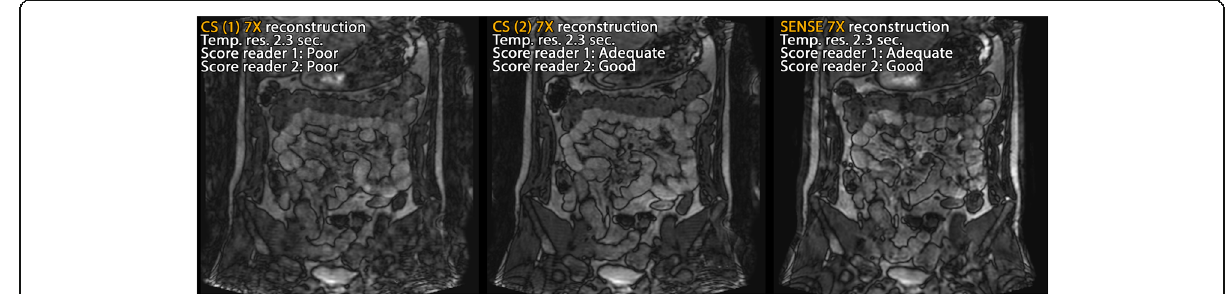
Fig. 9 Reconstructions from a representative time frame of a 7× accelerated dynamic acquisitions (dynamic experiment). Left: compressed sensing and parallel imaging (CS-PI) with equal sampling pattern (CS1). Middle: CS-PI with varying sampling pattern (CS2). Right: sensitivity encoding